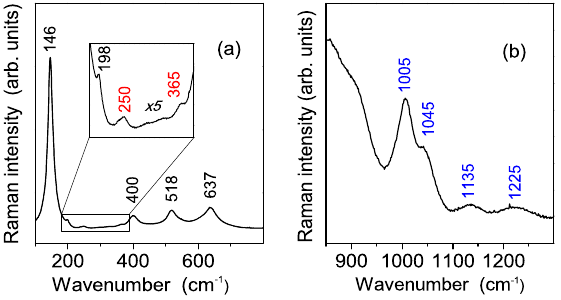
Figure 5. Experimental Raman spectra of the synthesized sample showing typical features of TiO 2 (panel a ) and of sulfate group SO 42 − (panel b ). The details about the spectra detection are provided in the text.